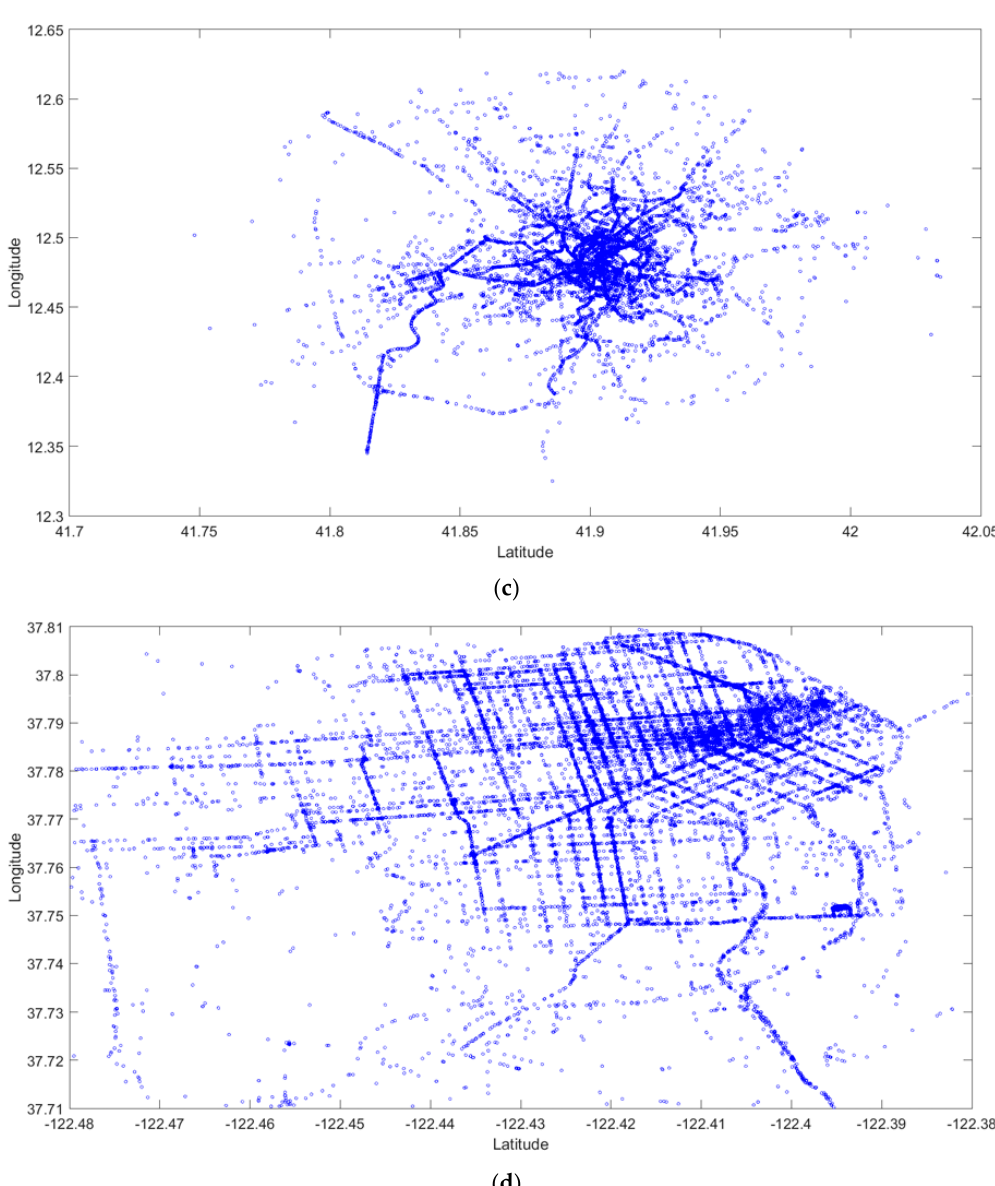
Figure 2. Distribution of origins and destinations (OD) of taxi Global Positioning System (GPS) data: ( a ) Aracaju (Brazil); ( b ) Chongqing (China); ( c ) Roma (Italy); ( d ) San Francisco (USA).